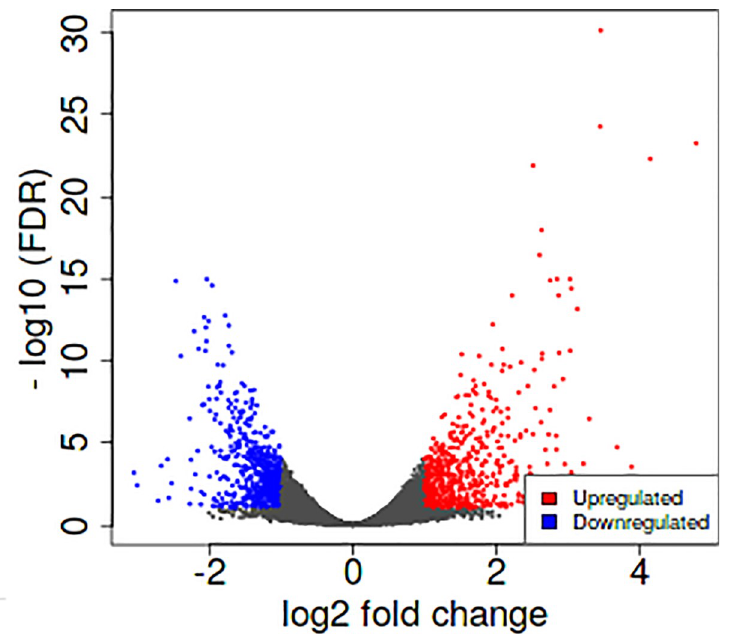
Fig 3. Volcano plot representation of differentially expressed genes between MAC-T and MAC-T BLV. Mean log2 fold change is plotted against the–log10 FDR for all the expressed genes. Red and blue dots represent genes with a significant increase or decrease expression,